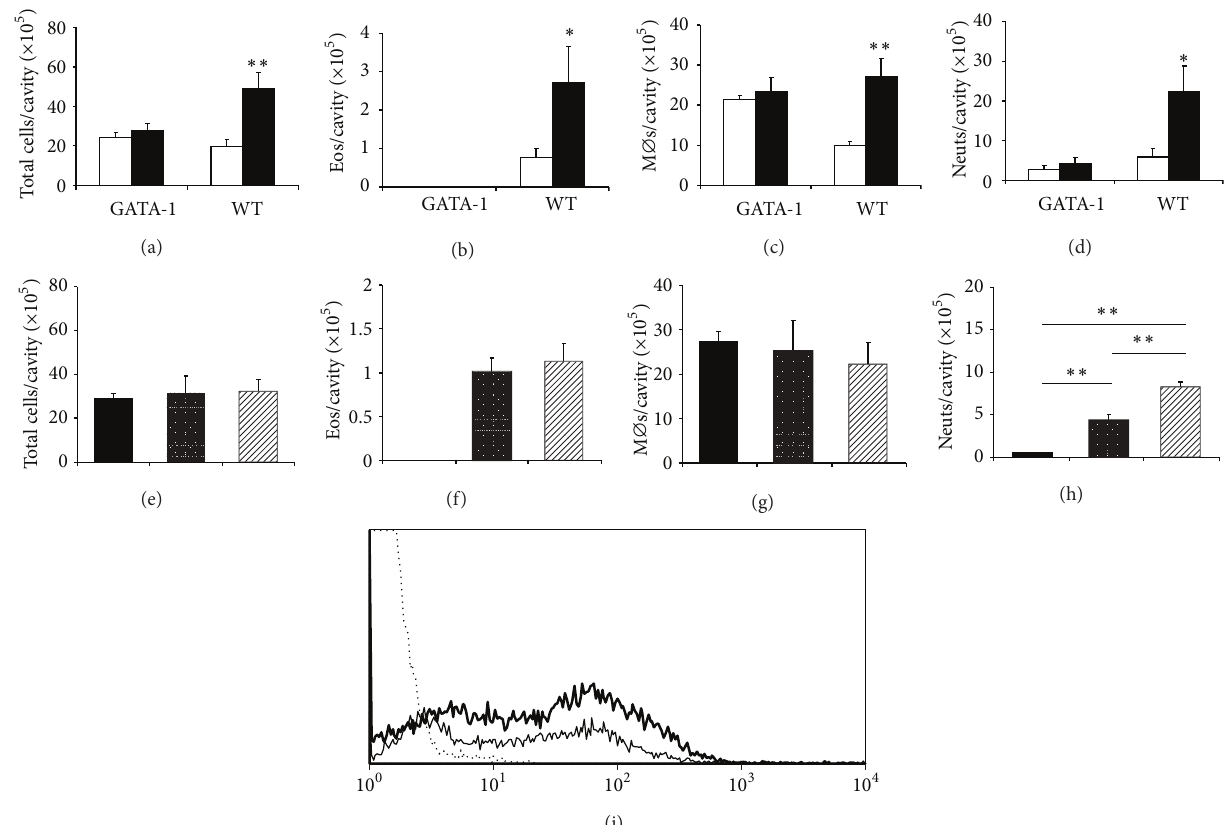
Figure 6: Effect of eosinophil transfer into GATA-1 recipients on neutrophil accumulation. (a)–(d) Eosinophil-deficient GATA-1 mice and wild-type (WT) controls (BALB/c) were injected with RPMI (open bars) or eotaxin, 50 ng/cavity (black bars). The peritoneal lavage fluid collected after 4 h was used for quantitation of total leukocytes (a), eosinophils (b), macrophages (c), and neutrophils (d). E-H, GATA-1 mice received eotaxin (black bars), BALB/c eosinophils (stippled bars), or BALB/c eosinophils followed by eotaxin administration 30 minutes later (hatched bars). Peritoneal lavage fluid collected after 4h of eotaxin administration was used for quantitation of total leukocytes (e), eosinophils (f), macrophages (g), and neutrophils (h). Data are mean ± SEM. ∗ , 𝑃 ≤ 0,05; ∗∗ , 𝑃 ≤ 0,01, for the indicated differences. Data from 3–11 experiments. (i) Intensity of CCR3 expression in granulocytes. Cells were collected 4h after eotaxin injection from the peritoneal cavity of GATA-1 and BALB/c donors and stained for CCR3. Representative MFI profiles for the granulocyte gate are shown. Dotted line, GATA-1. Thin line, BALB/c. Thick line, GATA-1 sample to which purified BALB/c eosinophils were added in vitro (up to 20% of total